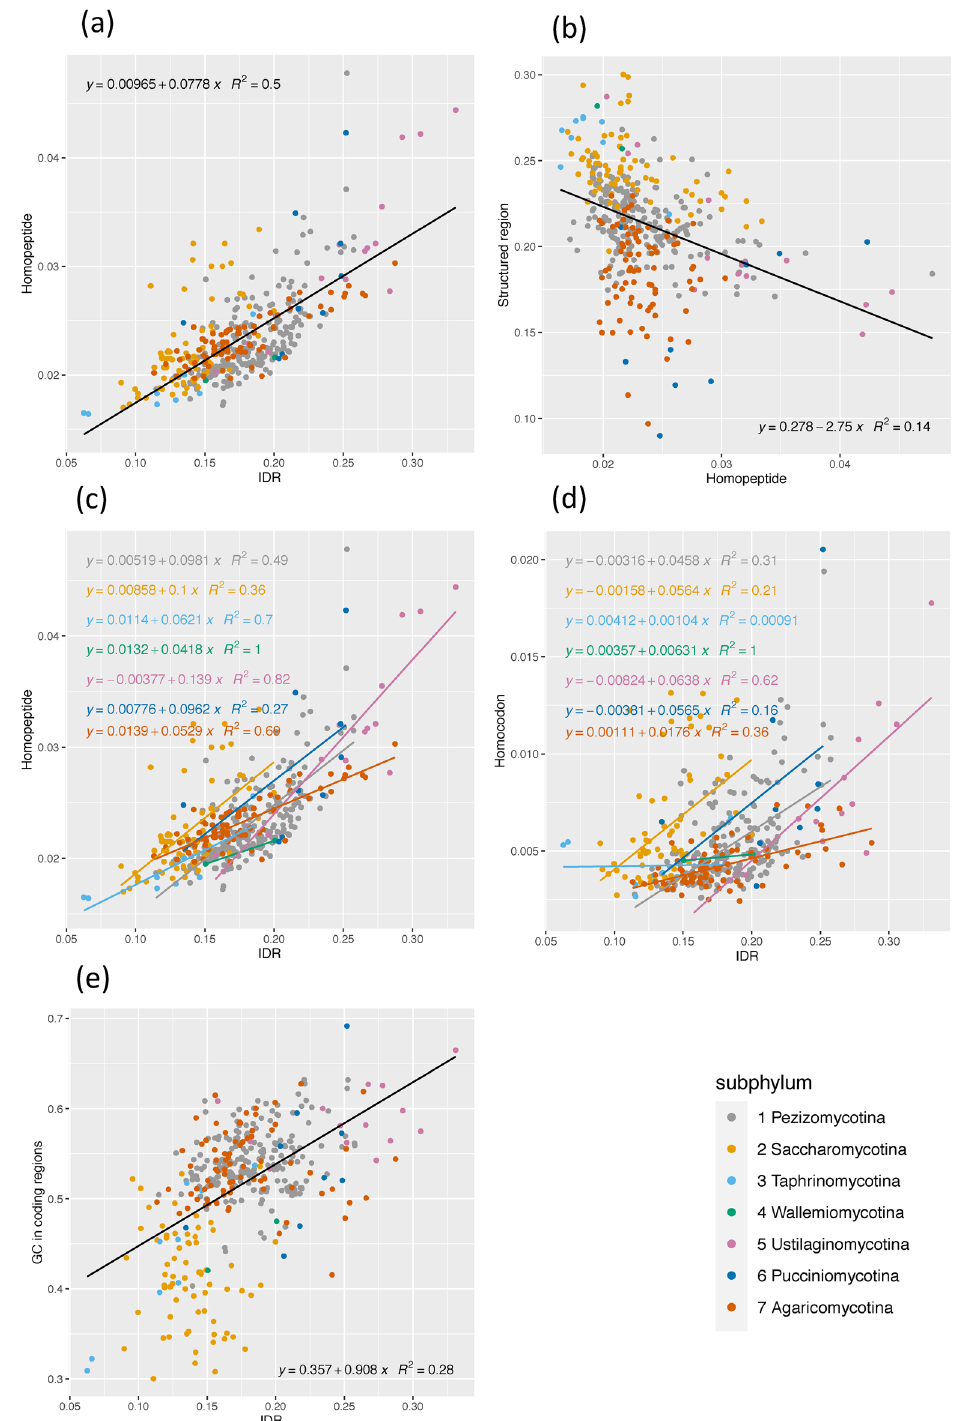
Figure 6. Relationship of homopeptide/homocodon fractions with intrinsic disorder, structured domains and GC content. Scatter plots are drawn of: ( a ) homopeptide fraction versus annotated IDR fraction, with an overall linear regression fitted ( P value < 0.00001). ( b ) homopeptide fraction versus fraction of structured domains, with an overall linear regression ( P value < 0.00001). ( c ) homopeptide fraction versus annotated IDR fraction, with linear regressions fitted for each subphylum. P values for correlations are < 0.05, except for Wallemiomycotina . ( d ) homocodon fraction versus annotated IDR fraction, with regressions for each subphylum (correlation P values are < 0.05, except for Wallemio- , Taphrino- and Pucciniomycotina ). ( e ) GC fraction in coding regions versus annotated proteome IDR fraction ( P value <